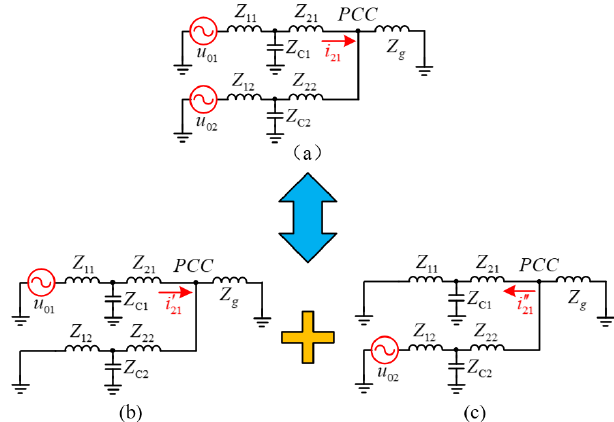
Figure 6. Circuit based on the superposition principle for paralleled inverters. ( a ) Equivalent circuit of two inverters with inductance-capacitance-inductance (LCL)-filter; ( b ) equivalent circuit when u 02 = 0; and ( c ) equivalent circuit when u 01 = 0.